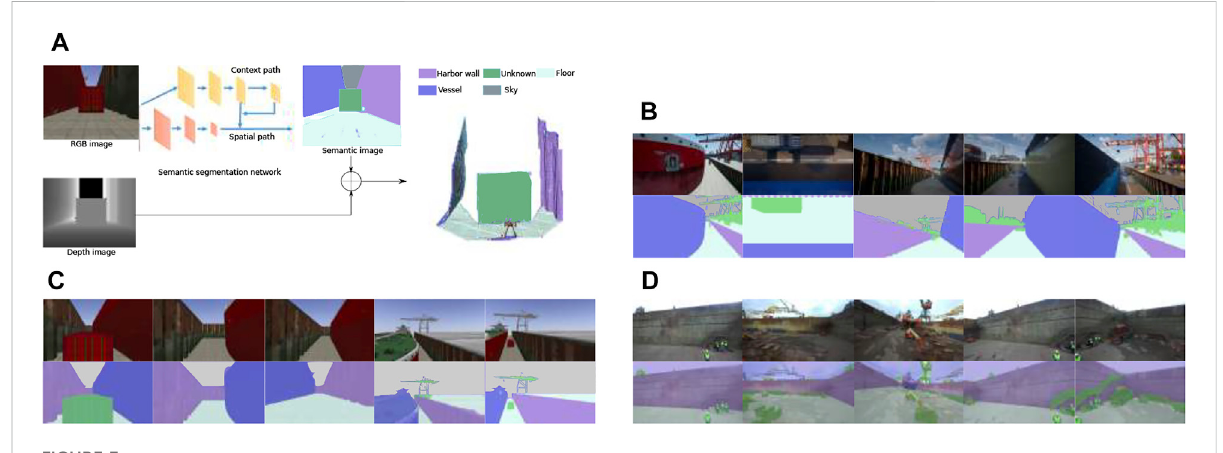
FIGURE 3 (A) Our architecture for 3D semantic segmentation. Sample training images collected in (B) Unreal Engine, (C) Gazebo, and a (D) real environment,